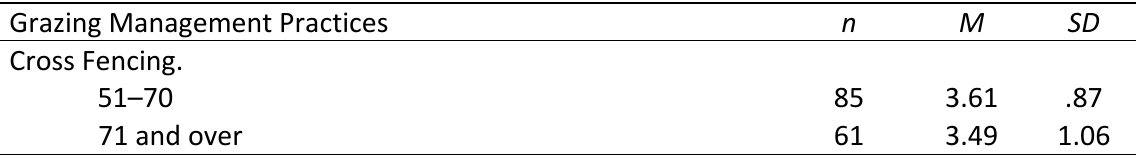
Descriptive Statistics of Age on Intention to Adopt Grazing Management Practices n M SD Cross